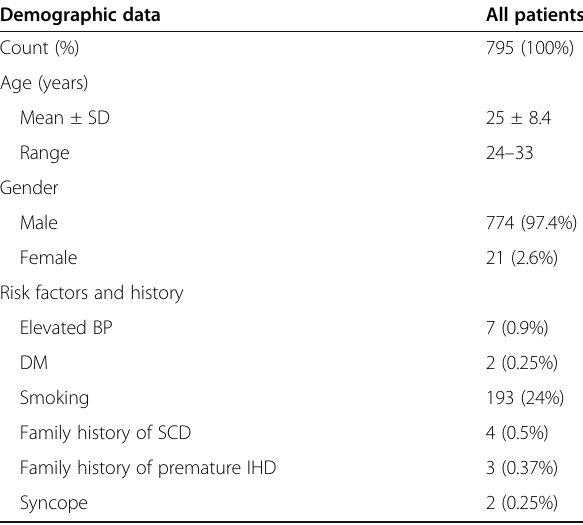
Table 3 Baseline demographic data of the whole